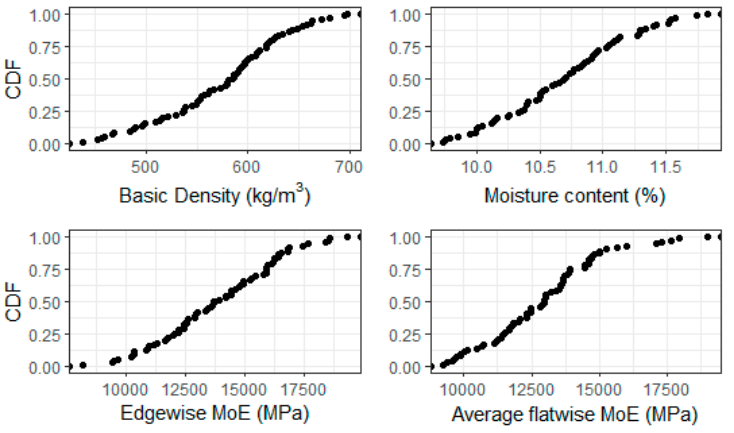
Figure 1. Cumulative distributions of mechanical parameters. The boards were ordered based on the average flatwise MoE value of 14~17 sections. For example, board number 1 had the highest mean